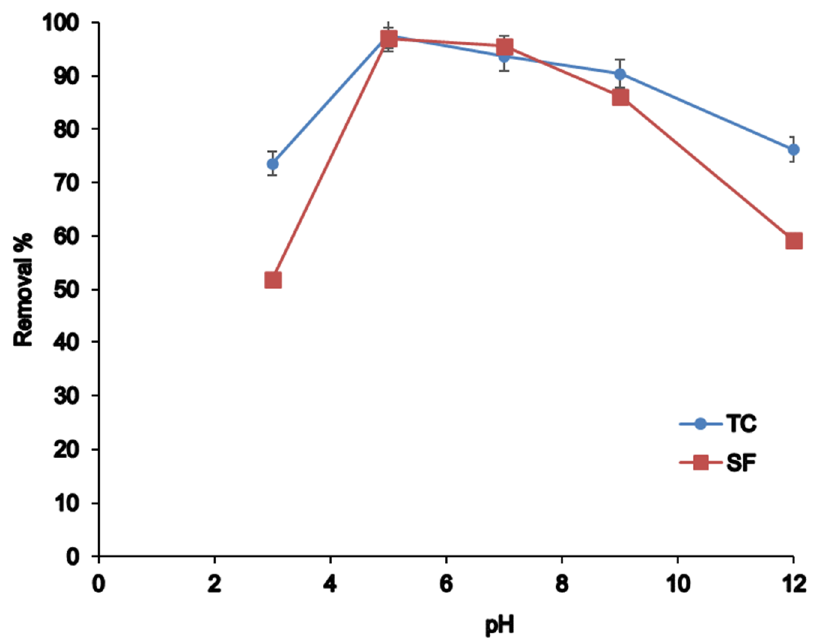
Figure 4. The effect of pH on the adsorption of TC and SF.